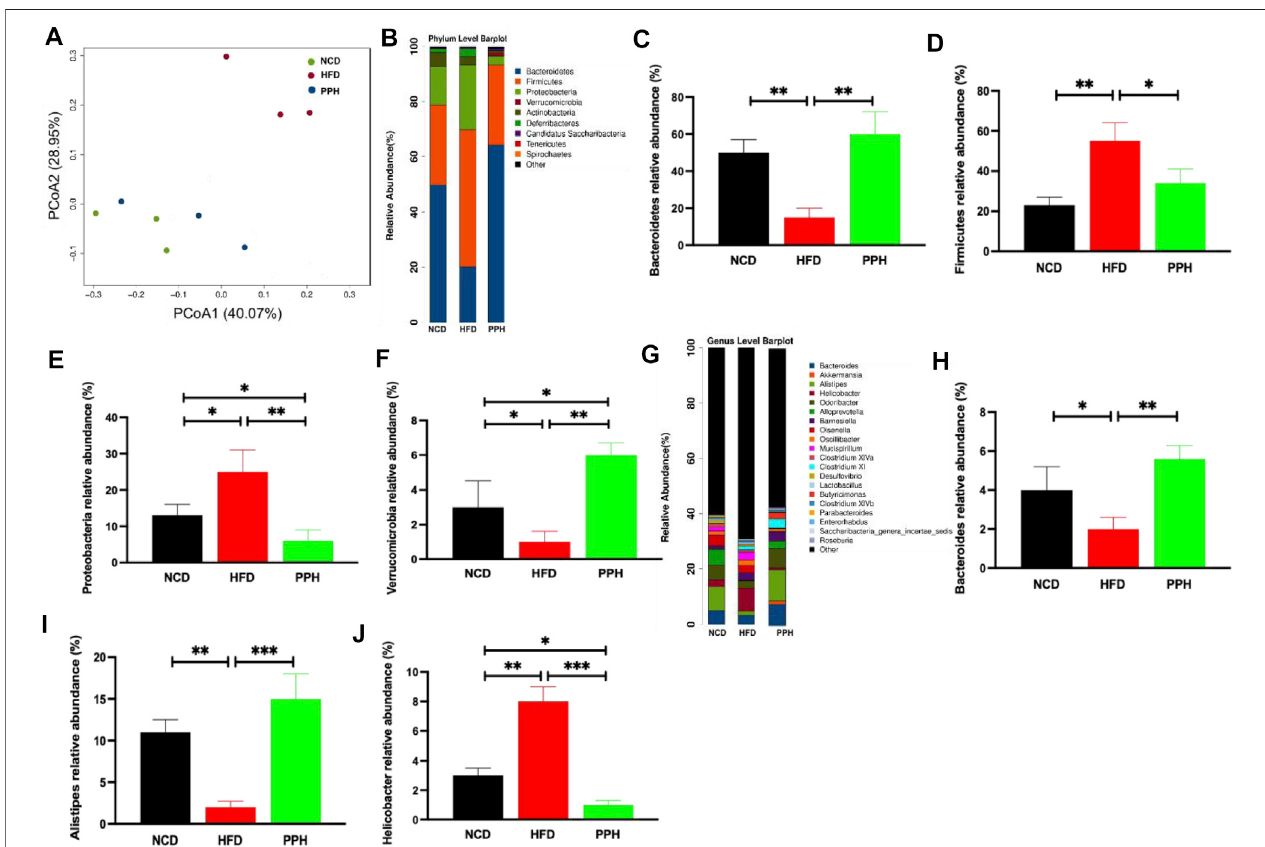
FIGURE8| EffectsofPPHonregulatingcolonicmicrobiota inobesemice.PCoAplotofcolonicmicrobiota basedonaweightedUniFracmetric (A) ;effectsofPPH on the relative abundance of gut microbiota at the phylum level (B) , such as Bacteroidetes (C) , Firmicutes (D) , Proteobacteria (E) , and Verrucomicrobia (F) ; Effects of PPHontherelativeabundanceofgutmicrobiotaatthegenuslevel (G) ,suchas Bacteroides (H) , Alistipes (I) ,and Helicobacter (J) .* p < 0.05,** p < 0.01,and*** p < 0.001.